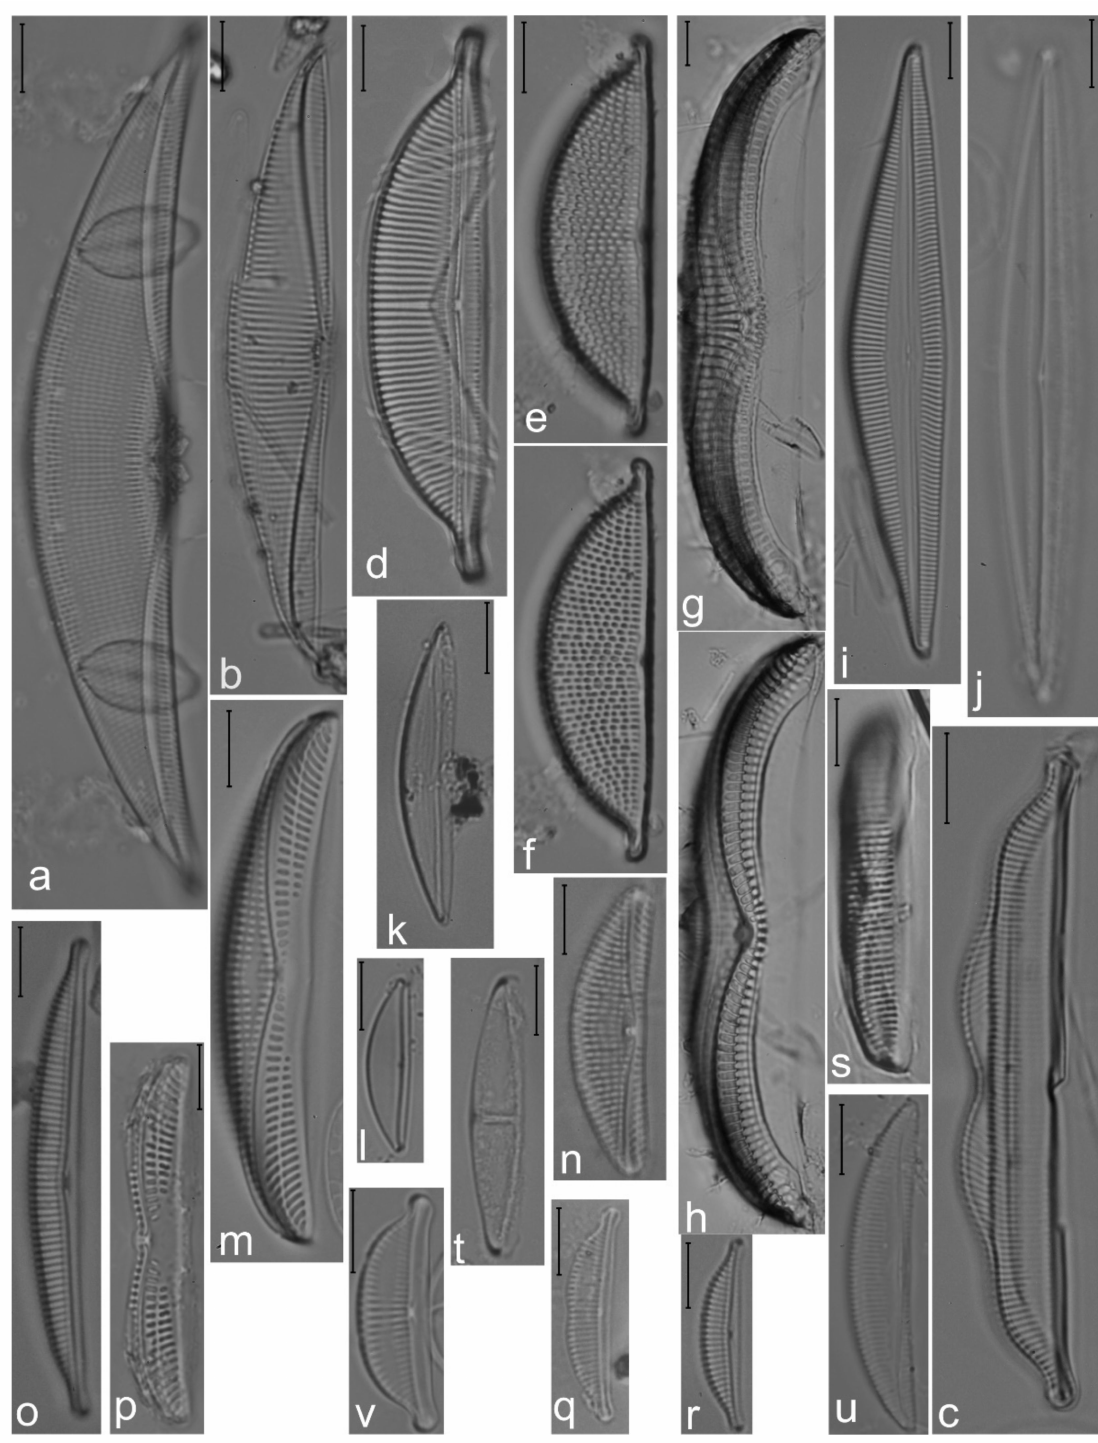
Figure 28. ( a ) Tetramphora intermedia ; ( b ) T . securicula ; ( c ) Amphora floridae ; ( d ) A . caroliniana ; ( e , f ) A . corpulenta var. capitata ; ( g , h ) A . robusta var. hemicostata ; ( i ) Seminavis robusta ; ( j – l ) S . delicatula ; ( m ) Amphora proteus ; ( n , q ) Halamphora exigua ; ( o ) H . lineata ; ( p ) Amphora aequalis ; ( r ) H . acutiuscula ; ( s ) Amphora proteoides ; ( t ) A . laevissima ; ( u ) A . graeffei var. minor ; ( v ) Halamphora turgida . Scale bar = 10 µ